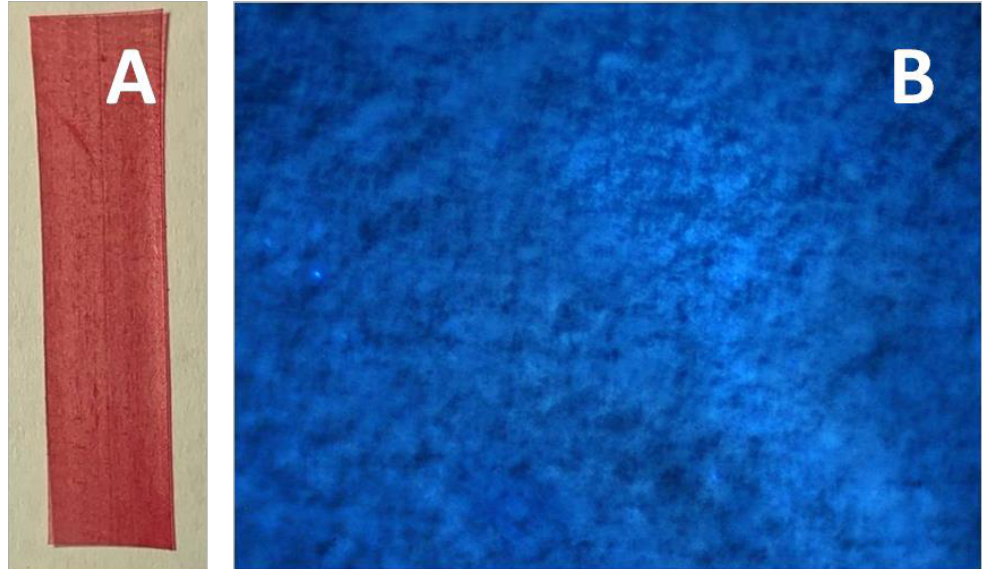
Figure 3. ( A ) Optical micrograph of the UHMWPE films after tensile drawing in O/W emulsion based on n -heptane and water (95 vol. %) contrasted by the oil-soluble dye Sudan IV (dye-contrasting tests) and ( B ) confocal fluorescence micrograph of the UHMWPE films after tensile drawing in n -heptane and dye-contrasting by the fluorescent dye Rhodamine 6G in IPA. Tensile strain is